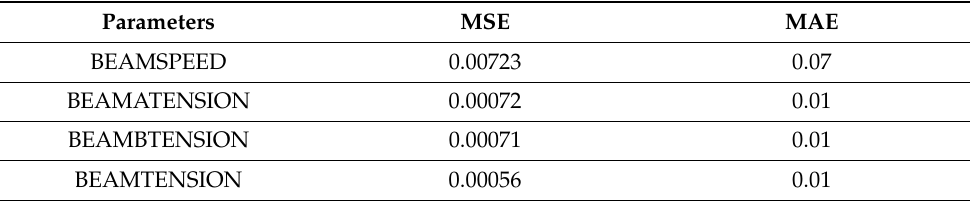
Table 15. Linear regression results for the beaming process.